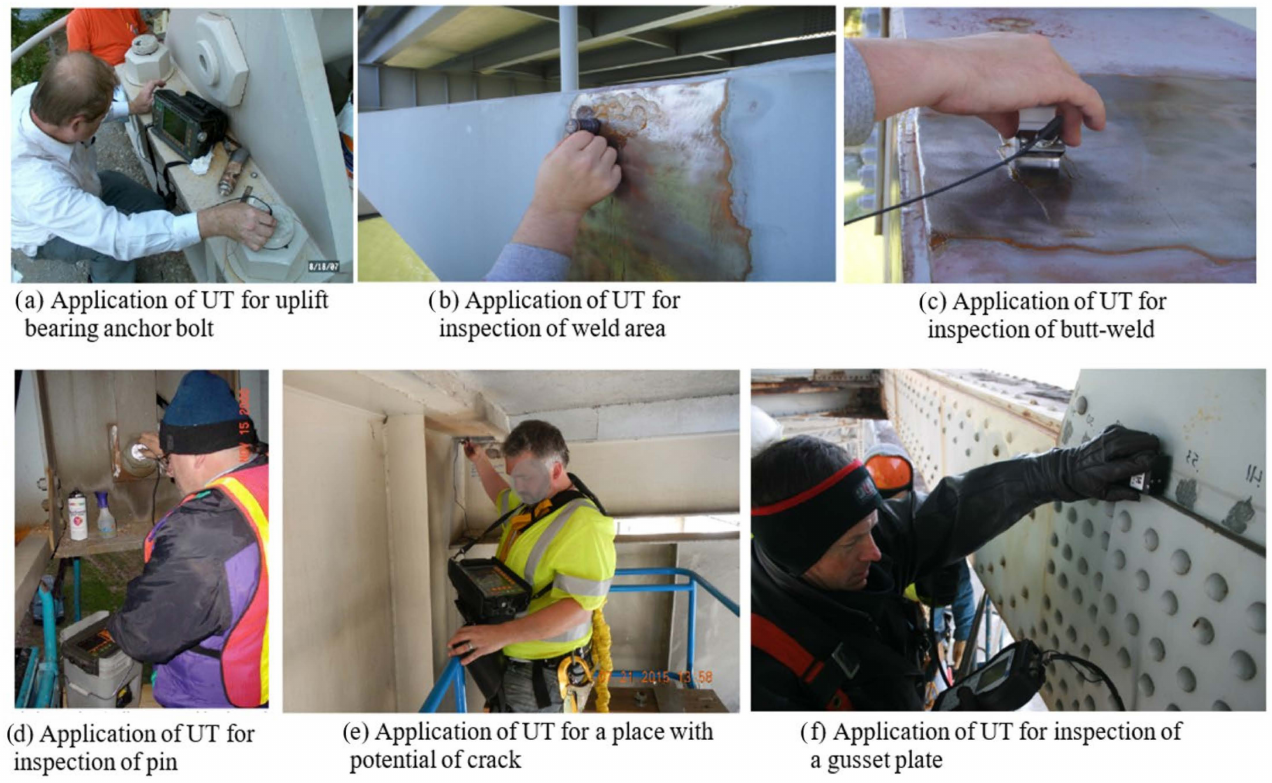
Figure 10. Applications of UT for steel bridges